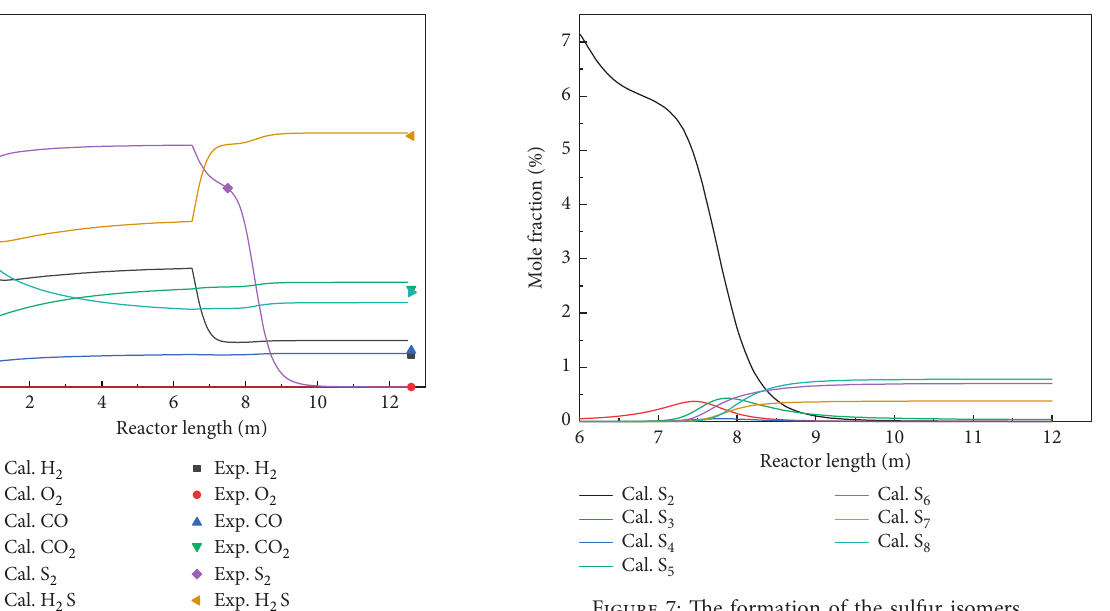
Figure 7: The formation of the sulfur isomers.